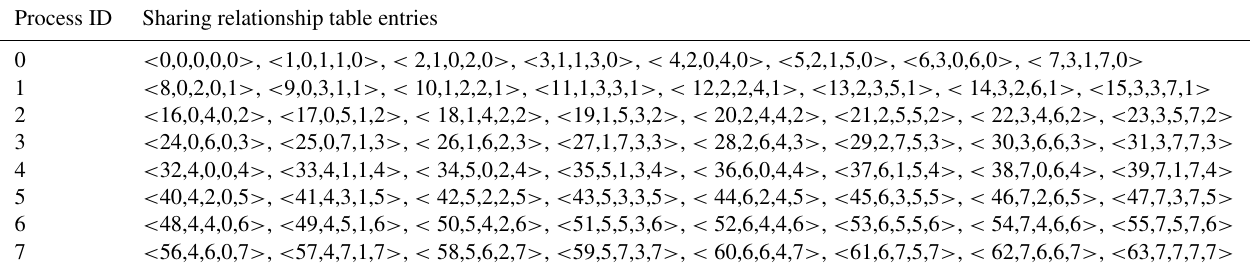
Table 4. The sharing relationship table (SRT) calculated from the rearranged distributed CLGMT entries in Fig. 3 and Table 3. Process ID Sharing relationship table entries